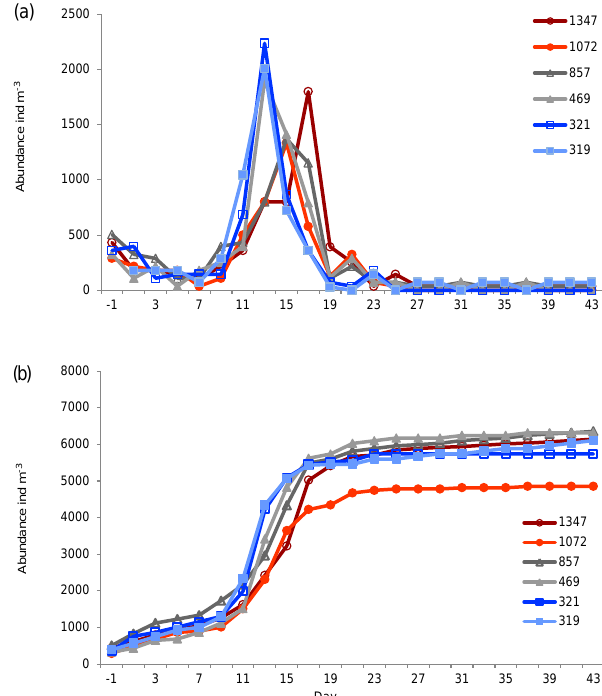
Figure 2. (a) The abundance of settled individuals per cubic metre water mass enclosed in the different mesocosms over the course of the experiment. (b) The cumulative abundance of settled M. balth- ica per cubic metre of individual mesocosm